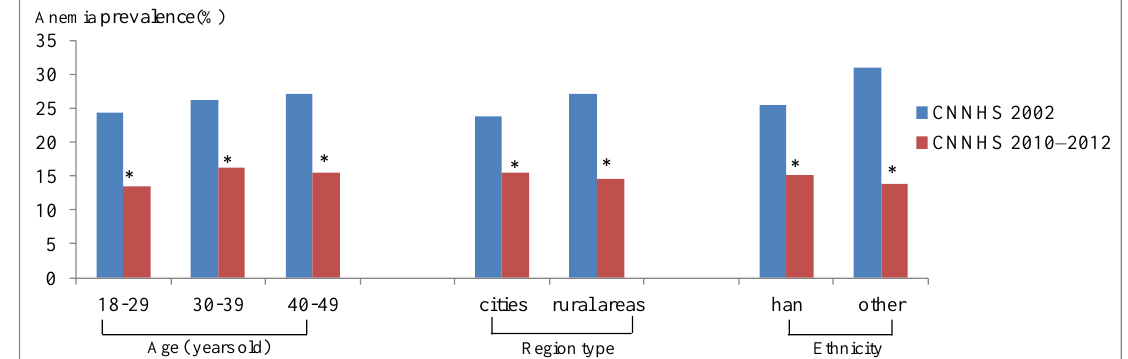
Figure 3. Prevalence of anemia for the fourth Chinese national nutrition and health survey (CNNHS 2002) and the fifth CNNHS 2010 – 2012, stratified by demographic characteristics. (*significant differences between CNNHS 2010 and 2002, P < 0.001).